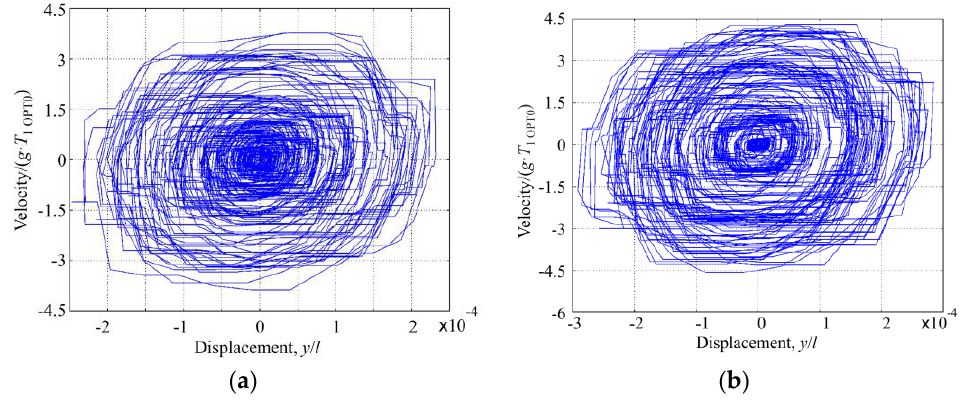
Figure 13. Phase diagram of the tip of randomly excited ( a ) microcantilever OPT 0 and ( b ) rational microcantilever OPT RAT.